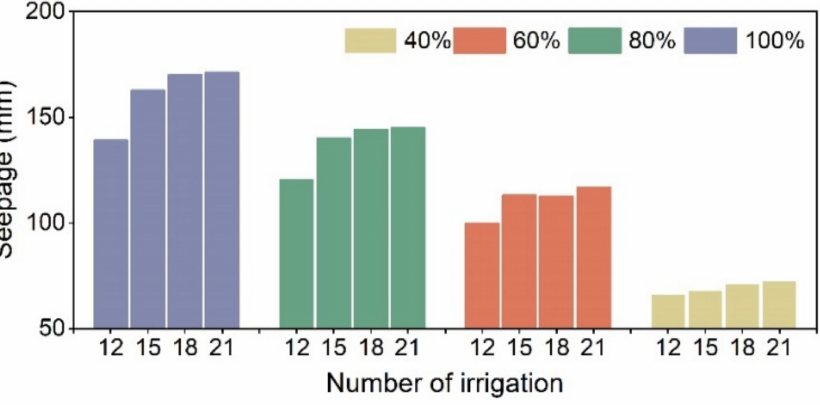
Figure 11. Simulation and comparison of cumulative seepage under different irrigation schedules.